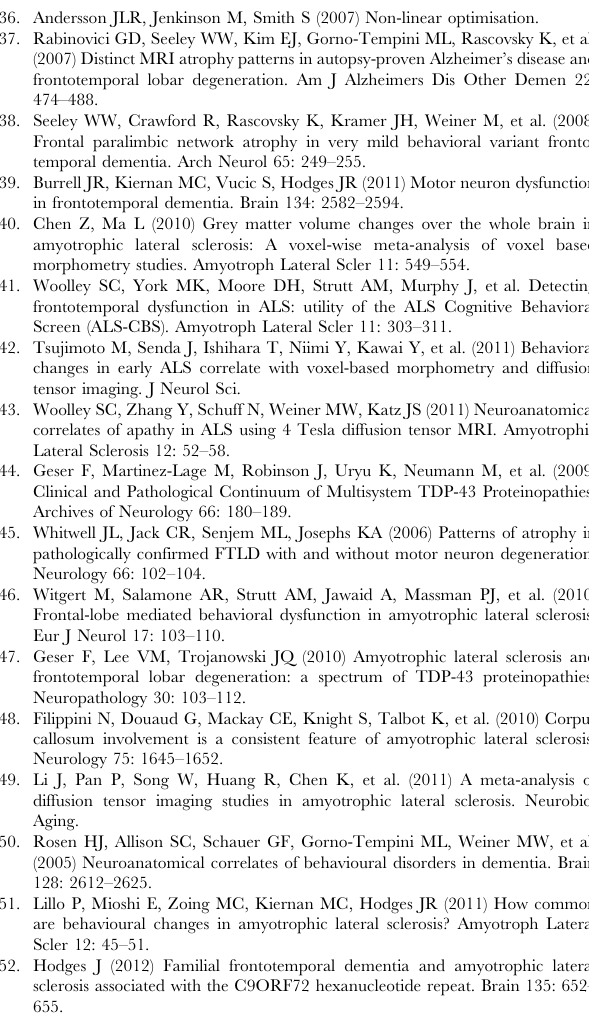
sclerosis associated with the C9ORF72 hexanucleotide repeat. Brain 135: 652–